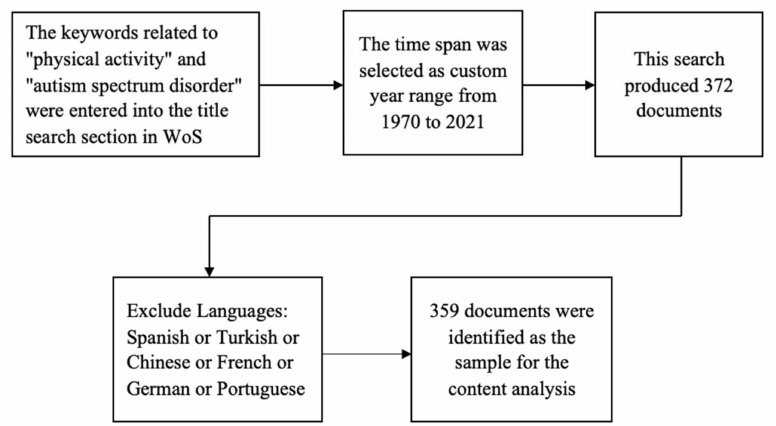
Figure 1. Flow chart of the document selection